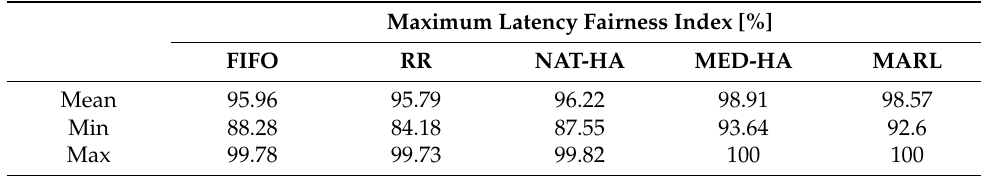
Figure 18. Box plot of maximum latency fairness index per scheduler from 10,000 episodes in topology 4 with the random flow. Table 11. Maximum latency fairness in topology 4 with random